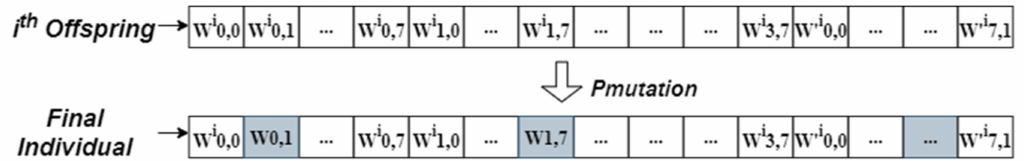
Figure 5. Uniform mutation with P mutation